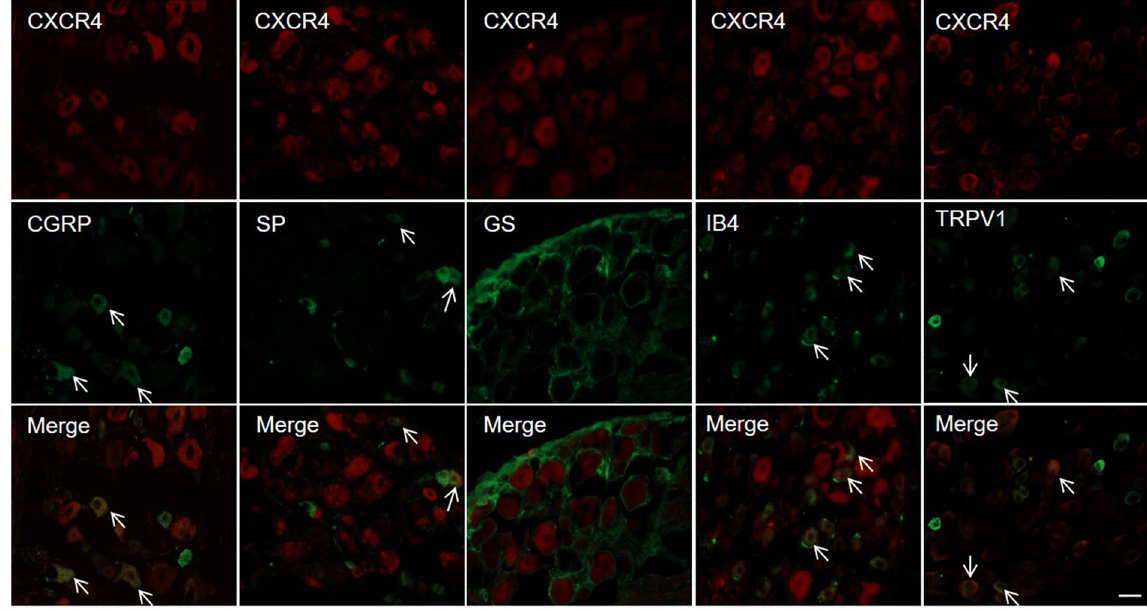
Figure 2. CXCR4 was co-expressed with IB4, SP, TRPV1 and CGRP in DRG neurons (arrows in merged image), but not in the satellite glial cells that were immunopositive for GS from CCD mice on postoperative day 7. Scale bar: 50 μ m.